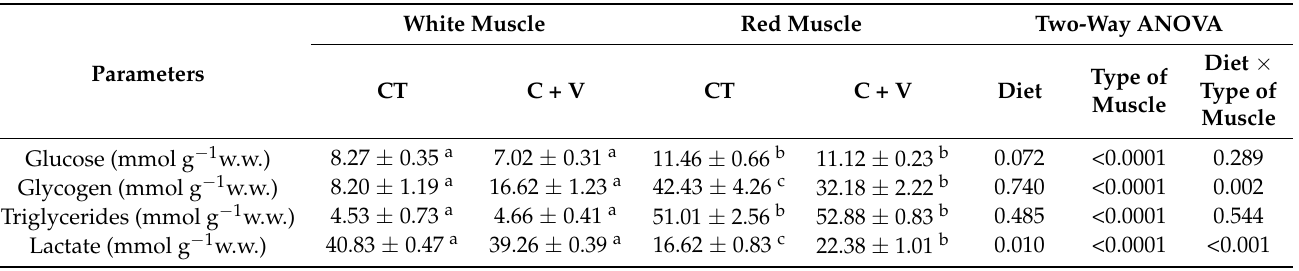
Table 7. White and red muscle metabolites in juvenile C. labrosus fed the control (CT) and C. fusca + V. proteolyticus (C + V) diets for 90